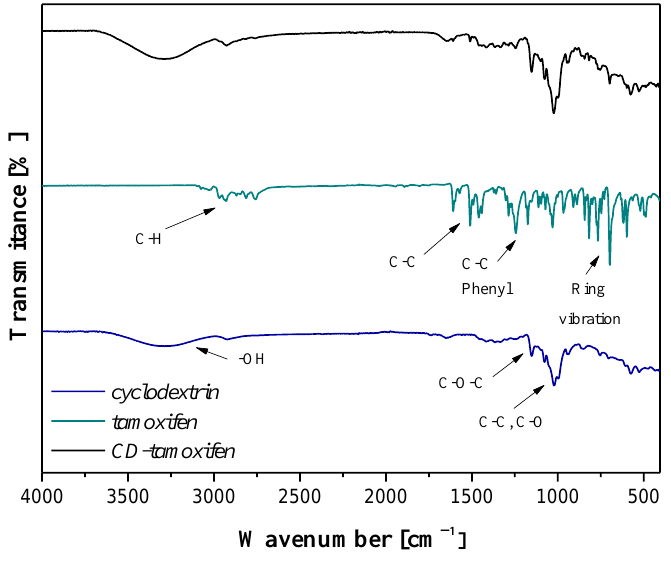
Figure 5. FT-IR spectra of tamoxifen, β -cyclodextrin and their complex (in a molar ratio 2:1).